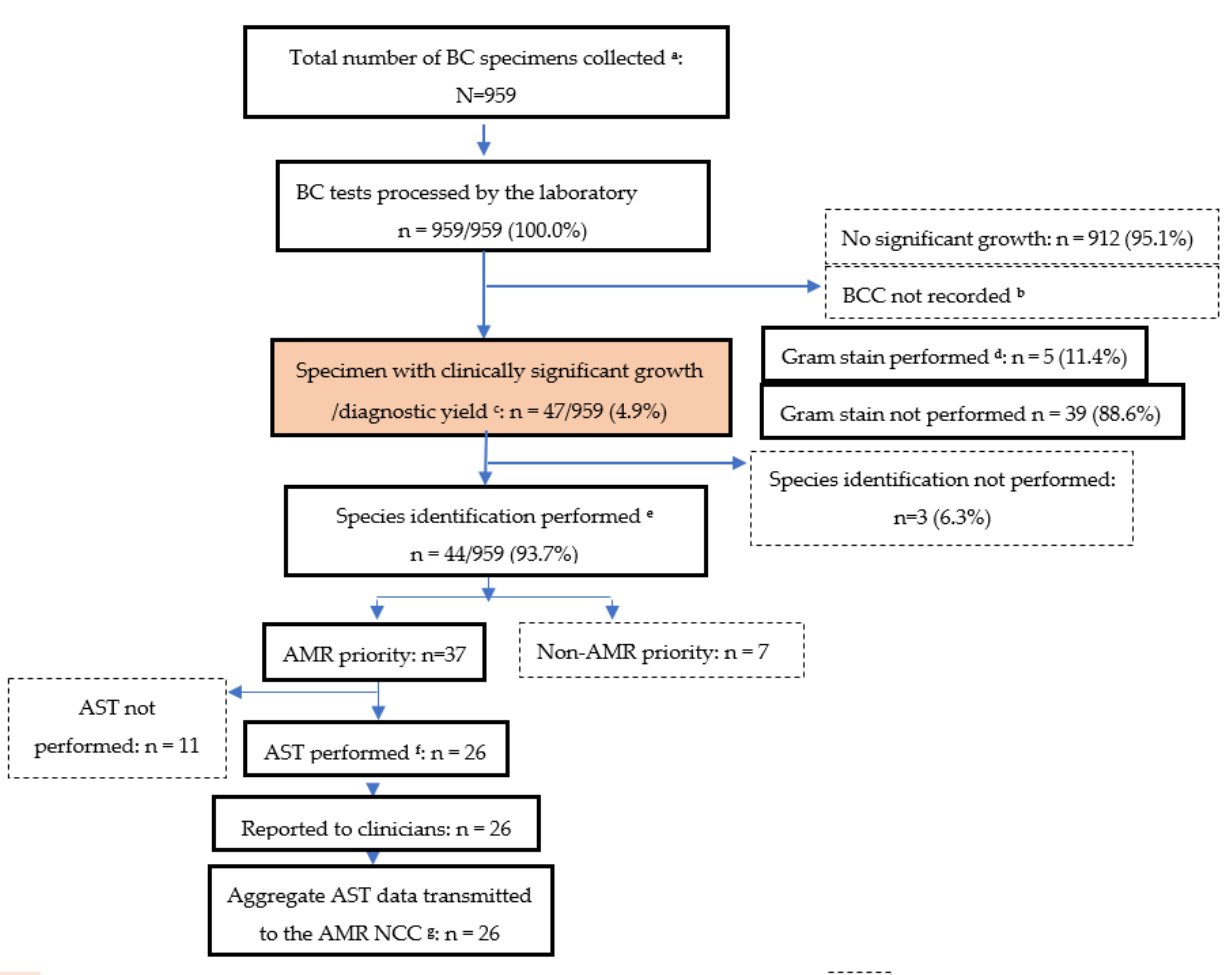
Figure 2. Cascade of blood culture positivity, isolate identification, and AST among hospitalized, non-malarial febrile patients undergoing blood culture at the five AMR surveillance sites in Uganda, October 2017–September 2018. a One BC specimen bottle collected from each child; b Performance target for BCC rates range from 2–3%; c Performance target for BC diagnsotic yield range from 6–12%. Only one isolate per specimen was included in our analysis; d Performance target for Gram-staining and reporting for all specimens showing clinically significant growth is 100%; e Performance target for pathogen identification and reporting is 100%; f Performance target for AST and reporting for all identified pathogens is 100%; g AST data for all AMR priority pathogens should be reported to clinicians and transmitted to the AMR